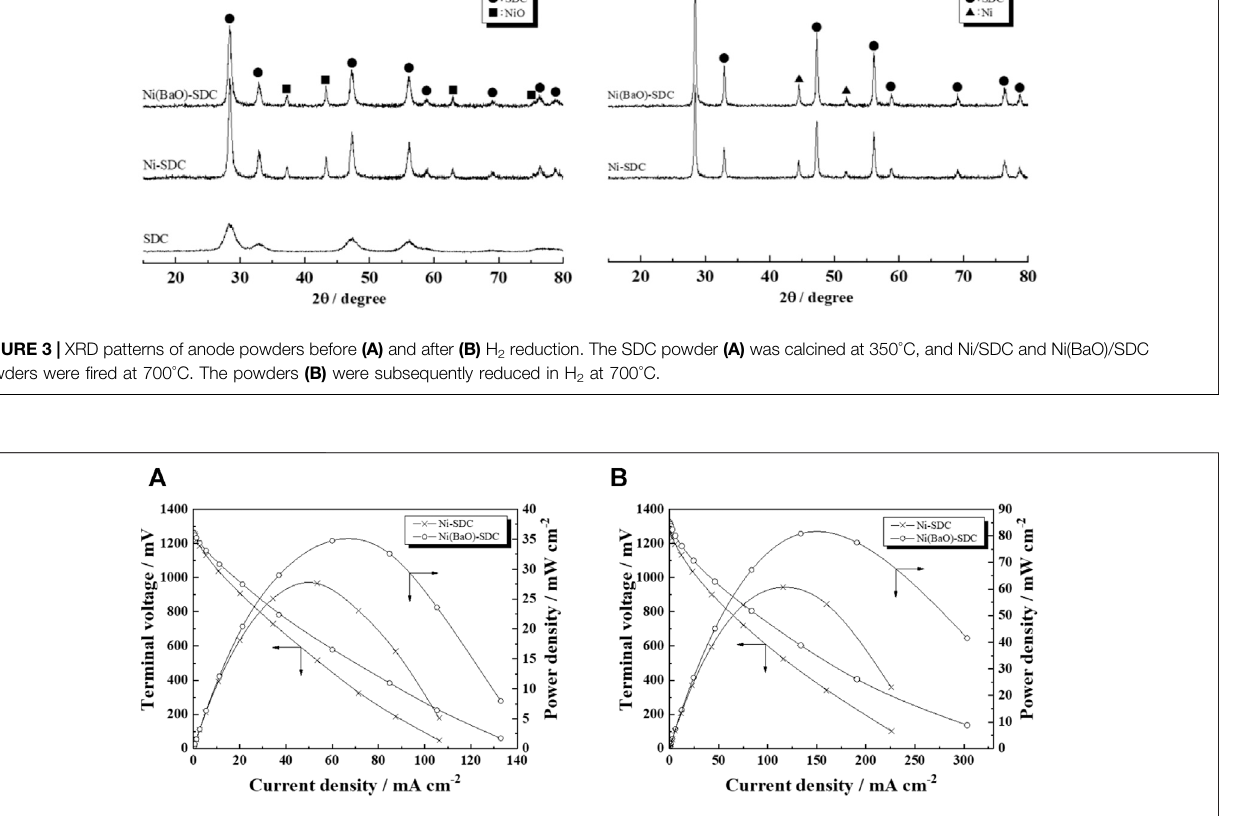
FIGURE 4 | The i – v and i – p characteristics of the cells with Ni/SDC and Ni(BaO)/SDC anodes at 700 ° C in H 2 (A) and CH 4 (B) fuels.